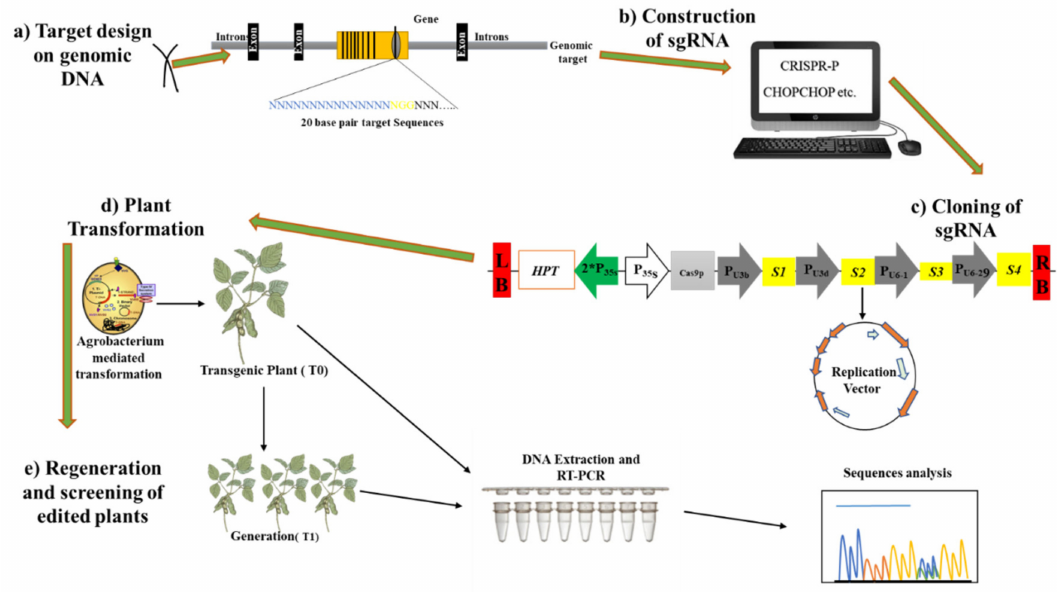
Figure 4. CRISPR / Cas9-based genome editing. ( a ) Selection of the desired target on genomic DNA and recognition of protospacer adjacent motif (PAM) sequences before 20-base-pair sequences. ( b )